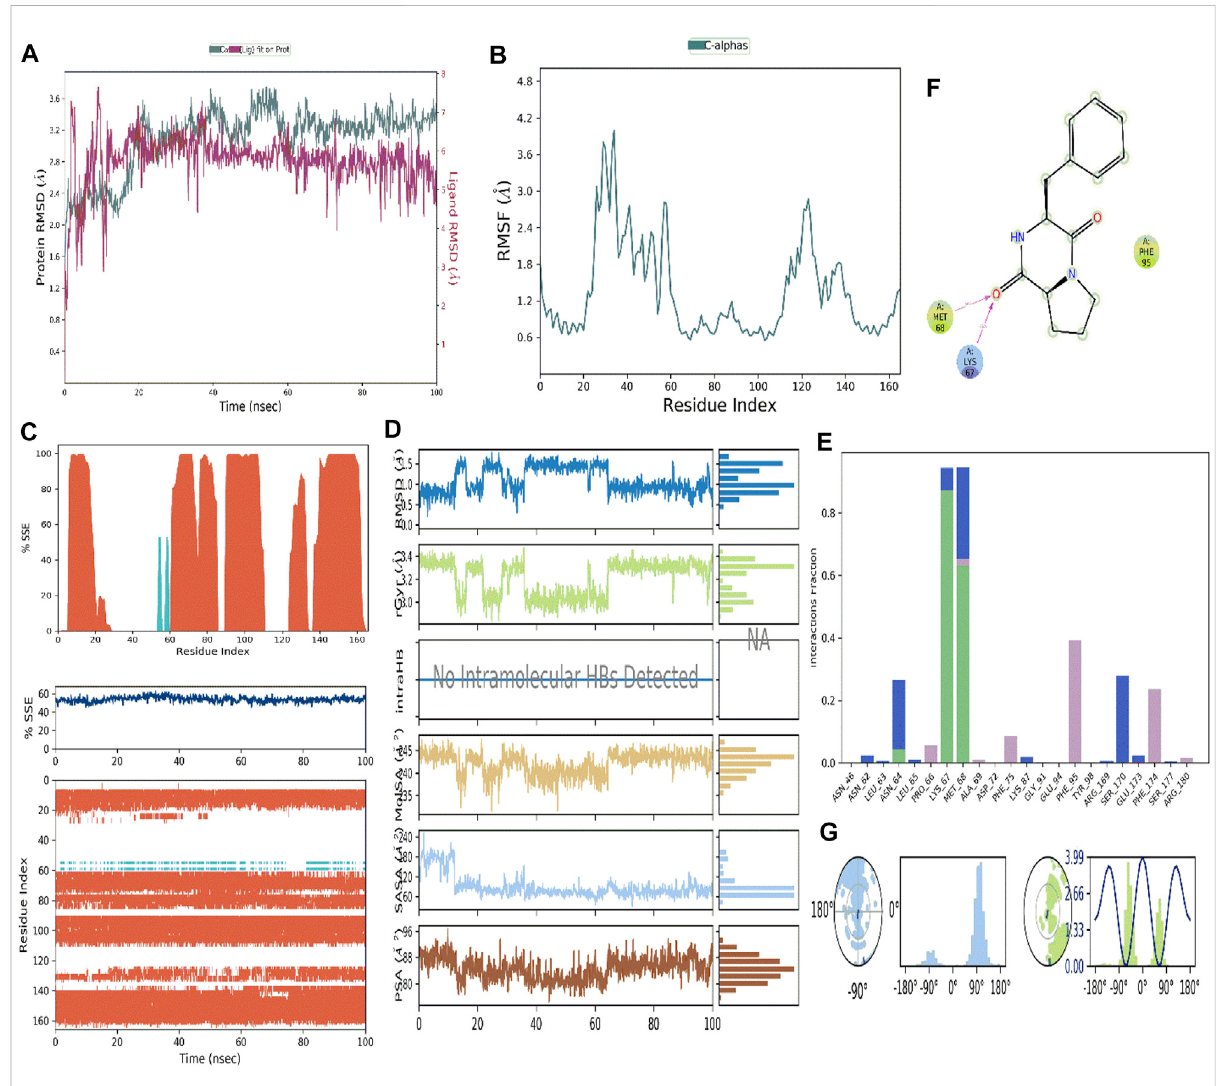
FIGURE 13 (A) RMSDanalysisofCDPDP-IL-6proteincomplex (B) RootMeanSquareFluctuation(RMSF)RMSFanalysisofCDPDP-IL-6proteincomplex (C) ProteinSecondaryStructureelementdistributionbyresidueindexthroughouttheproteinstructurescomplexedwithligandCDPDP-IL-6 (D) Ligand properties with IL-6 protein (E) Protein-ligand contact histogram of CDPDP-IL-6 (F) Protein-ligand interaction of CDPDP-IL-6 (G) Ligand torsional plot of